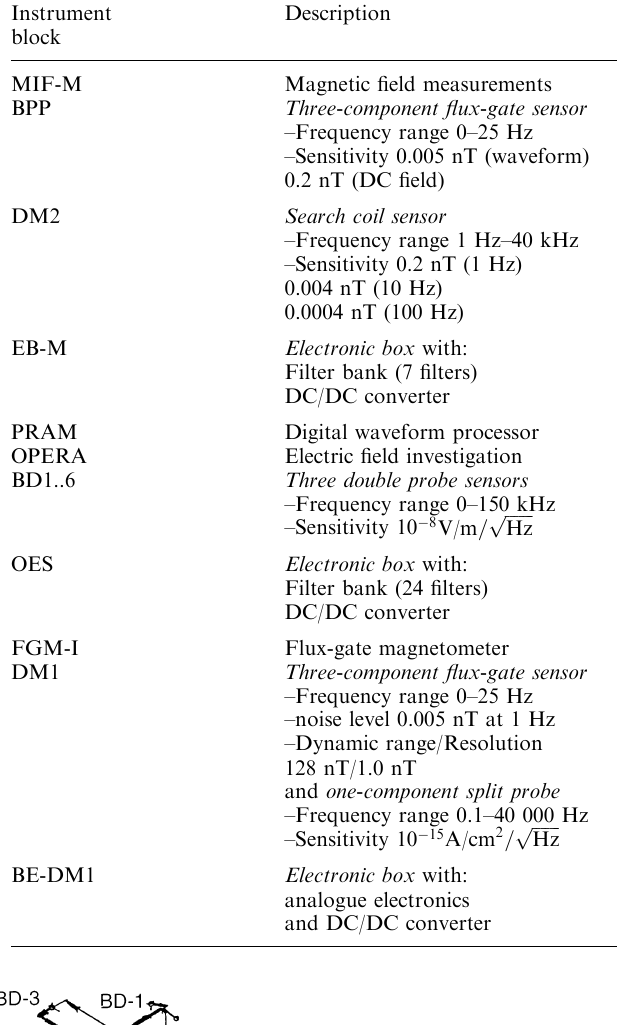
Table 1. Composition of the ASPI